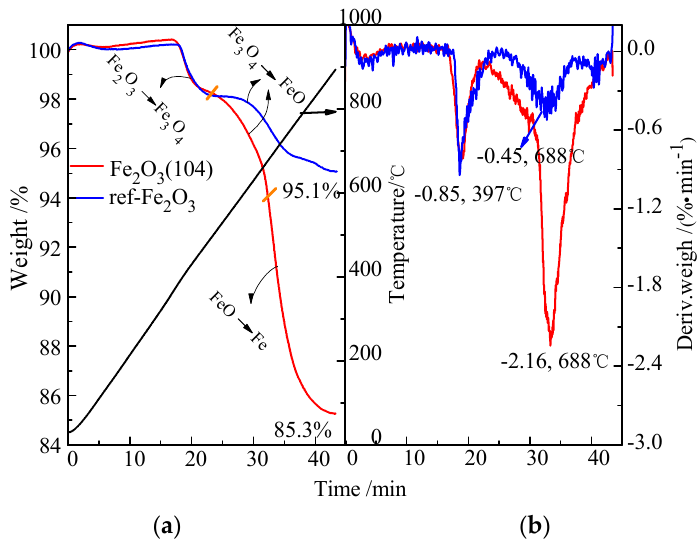
Figure 4. TG/DTG curves for reactions between CO and Fe 2 O 3 (104)/Al 2 O 3 or referenced Fe 2 O 3 /Al 2 O 3 . ( a ) TG curves; ( b ) DTG curves.